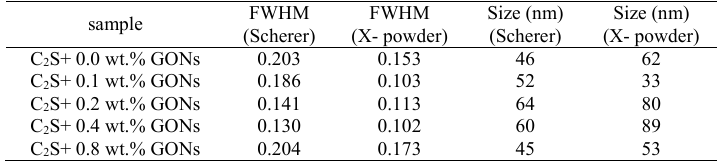
Fig. 3. X- Powder measurement of crystallite phase and β (FWHM): (a) C S, (b) C S+ 0.1 wt.% GONs, (c) C S+ 0.2 wt.% GONs, 2 2 2 (d) C Figure 3 . X- Powder measurement of crystallite phase and β (FWHM): (a) C 2 S, (b) C 2 S+ 0.1 Table 5. Dimensions of dominated peak at 30 o for C 2 S+ 0.1, 0.2, 0.4 and 0.8 wt.% GONs nanocrystals wt.% GONs, (c) C 2 S+ 0.2 wt.% GONs, (d) C 2 S+ 0.4 wt.% GONs and (e) C 2 S+ 0.8 wt.% GONs Table 5. Dimensions of dominated peak at 30 o for C S+ 0.1, 0.2, 0.4 and 0.8 wt.% GONs 2